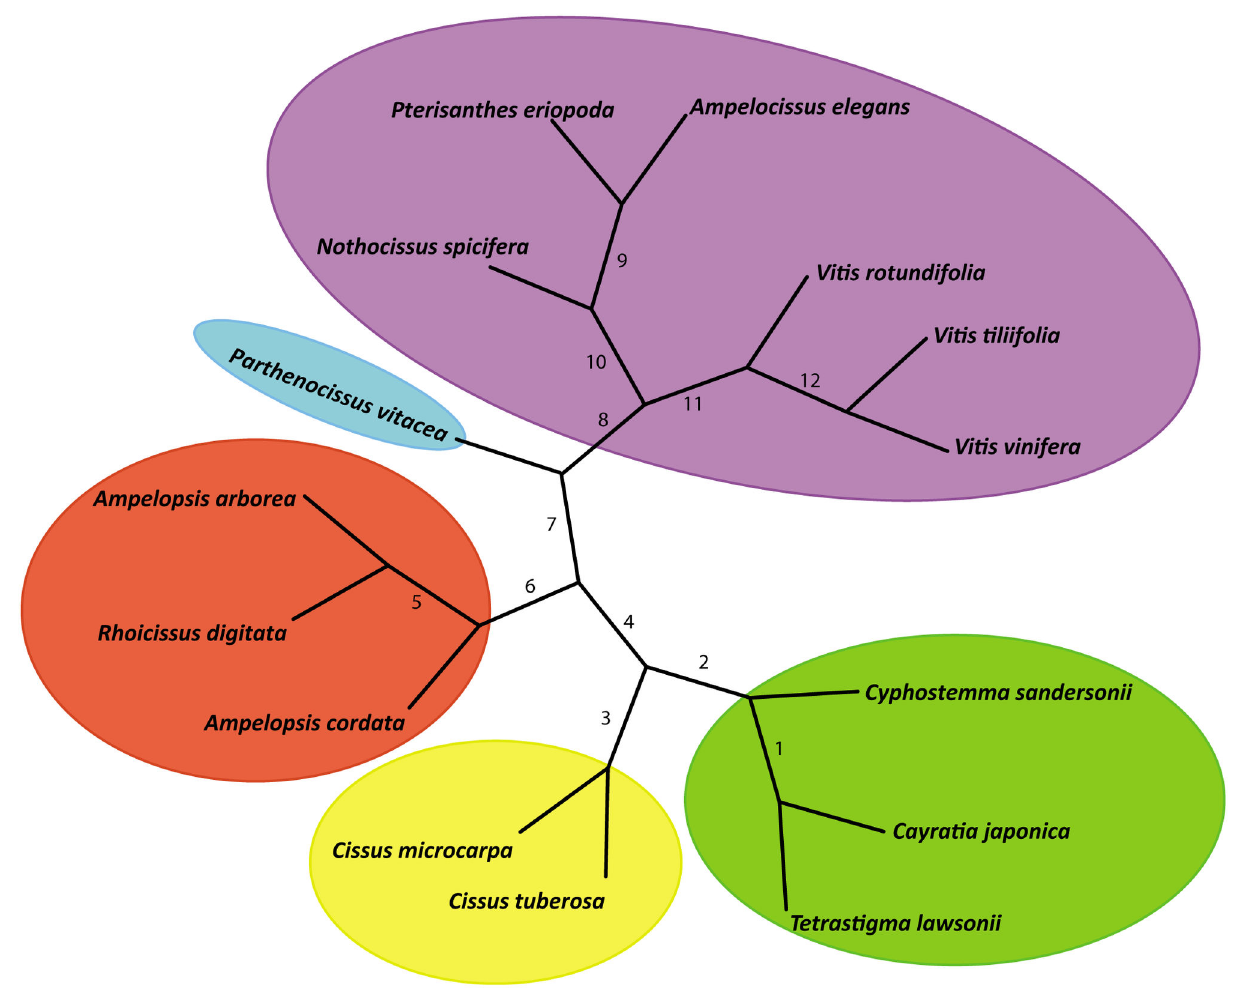
Figure 2. Unrooted tree of 15 species of Vitaceae based on nucleotide sequences of 229 genes. The node numbers correspond to those in Table